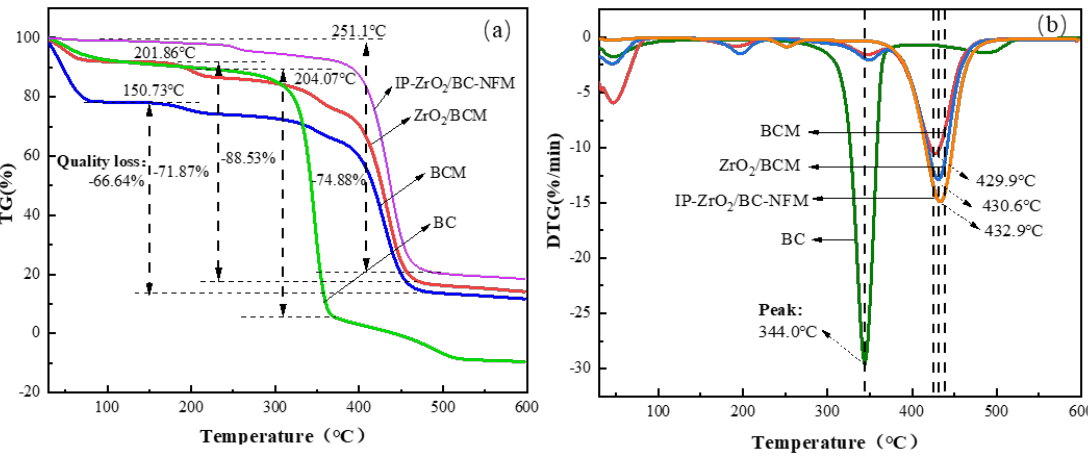
Figure 12. ( a ) TG and ( b ) DTG analysis outcomes of BCM, ZrO 2 /BCM, and IP − ZrO 2 /BC −